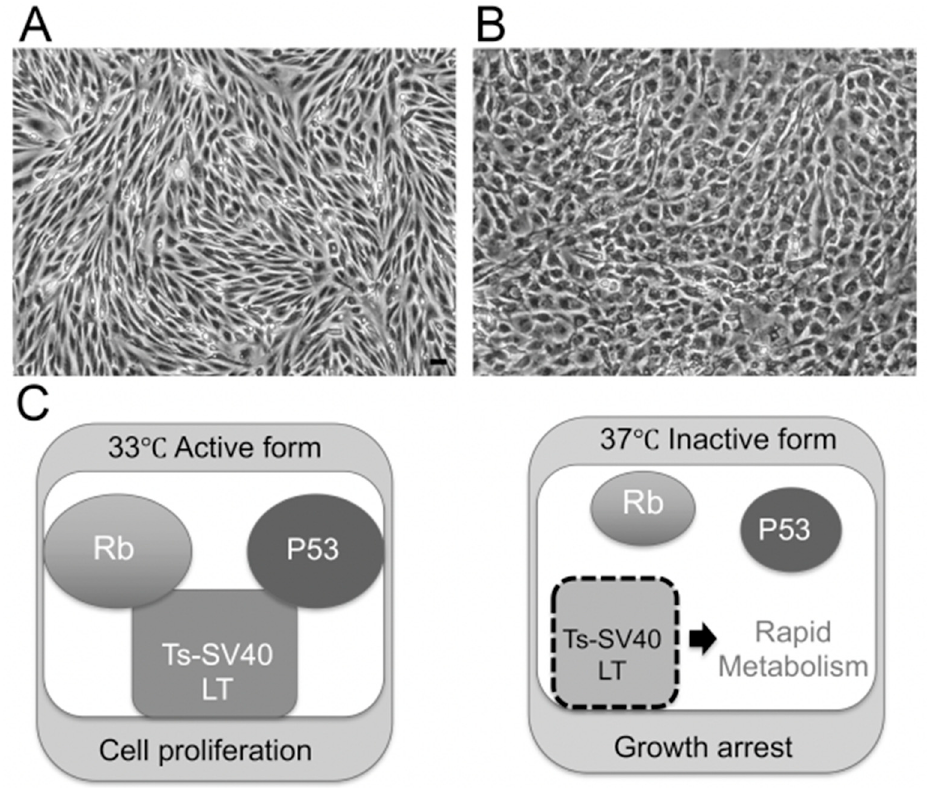
Figure 2. Establishing the BNB cell lines that maintain BNB properties. ( A ) Morphology of hEC-BNB (human endothelial cells in BNB) is spindle-shaped. ( B ) Morphology of hPCT-BNB (human pericytes in BNB) is cobblestone-shaped. ( C ) Temperature-sensitive SV40 large T antigen. At 33 °C, TS-SV40-LT binds and inhibits p53 and Rb, which are strong tumor suppressors, leading to continuous cell proliferation. At 37 °C, TS-SV40-LT is inactivated, and the cells exhibit growth arrest and differentiate into endothelial cells. Scale bar represents 10 μ m.